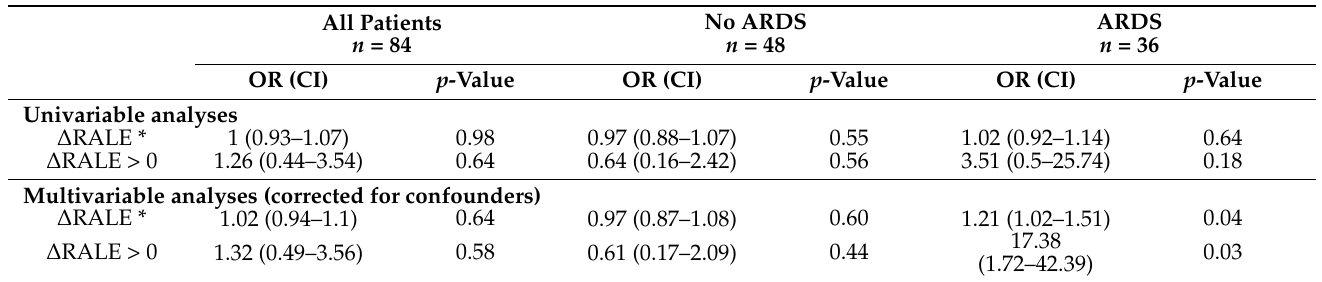
Table 3. ∆ RALE and 30-day